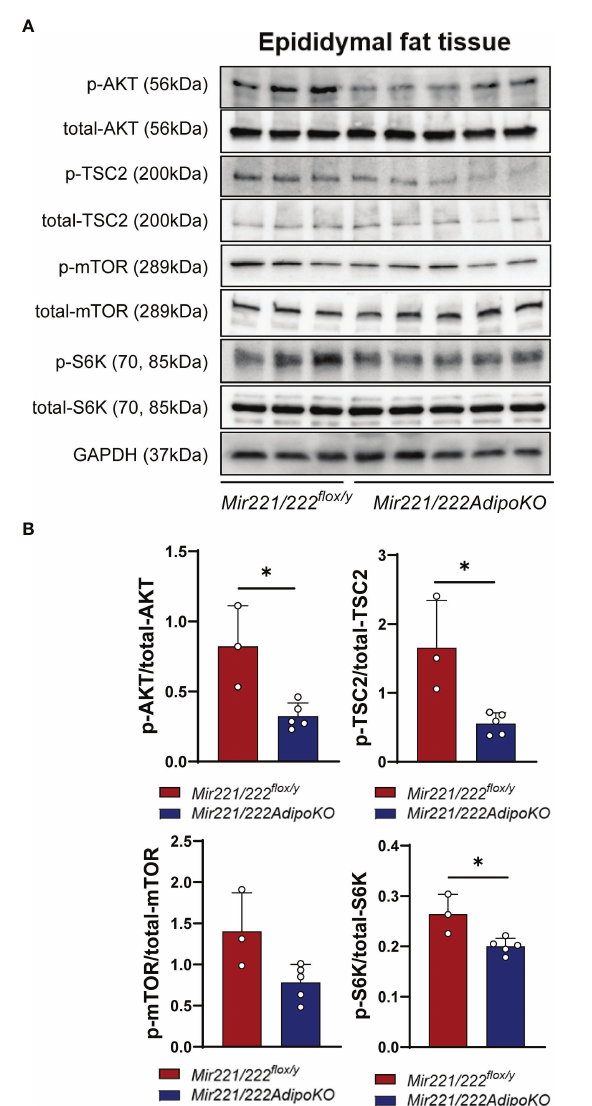
FIGURE 4 | Western blot analyses. (A) Western blot analyses for AKT (protein kinase B), TSC2 (tuberous sclerosis complex 2), mTOR (mammalian target of rapamycin) and S6K (ribosomal protein S6 kinase) in Mir221/222 fl ox/y (n=3) and in epididymal adipose tissues of Mir221/222AdipoKO (n=5) male mice fed with high fat high sucrose (HFHS). Activated form of p-AKT and Inactivated form of p-TSC2 (Thr-1462) and activated form of p-S6K are shown. (B) Densitometric analyses of Western blots. Data shown as mean ± SD and analyzed by Mann- Whitney ’ s U test (*p<0.05).